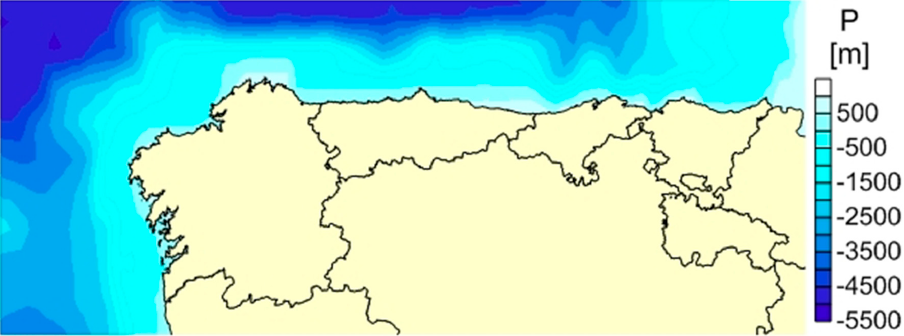
Figure 4. Bathymetry of the north of Spain.